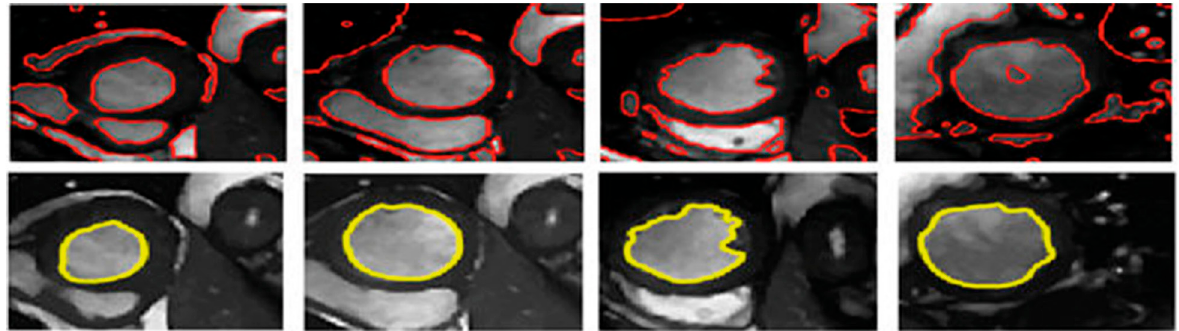
Figure 1. Images in the 1st row show inaccurate automated segmentation, while images in the 2nd-row show corresponding manual segmentation. Image courtesy of [6].